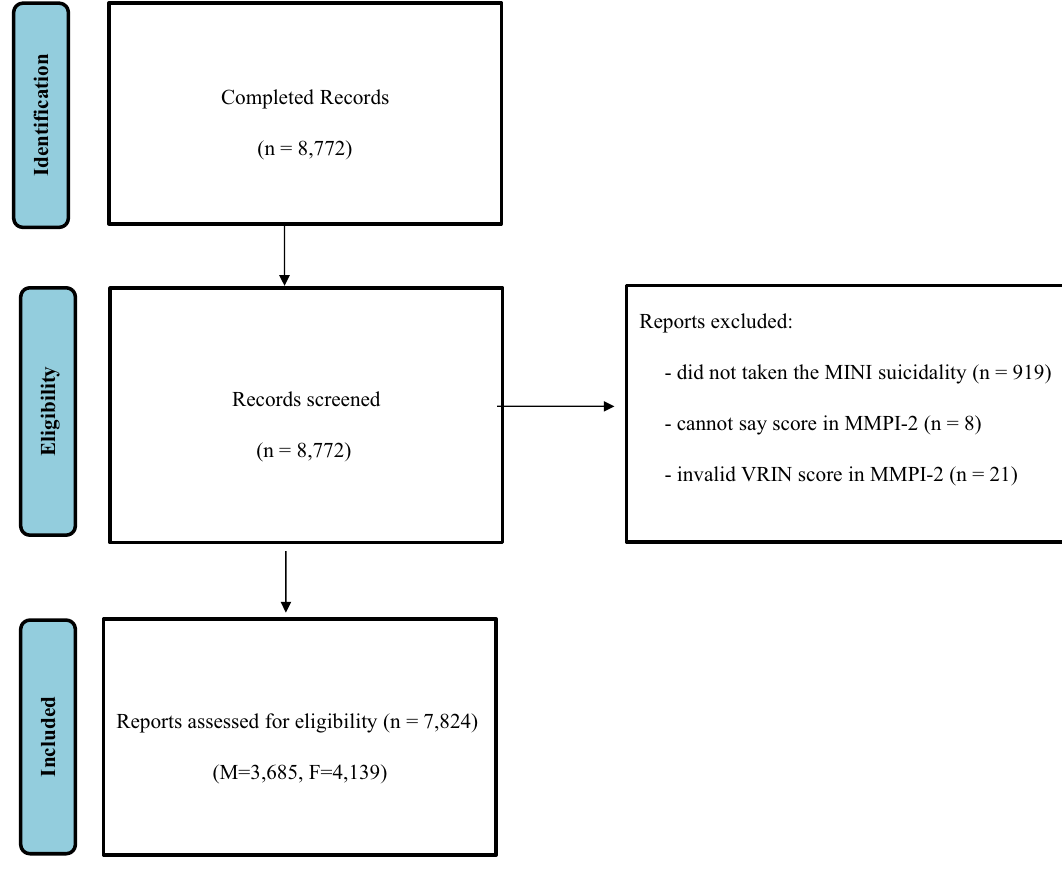
Figure 3. Flow chart of participants inclusion and